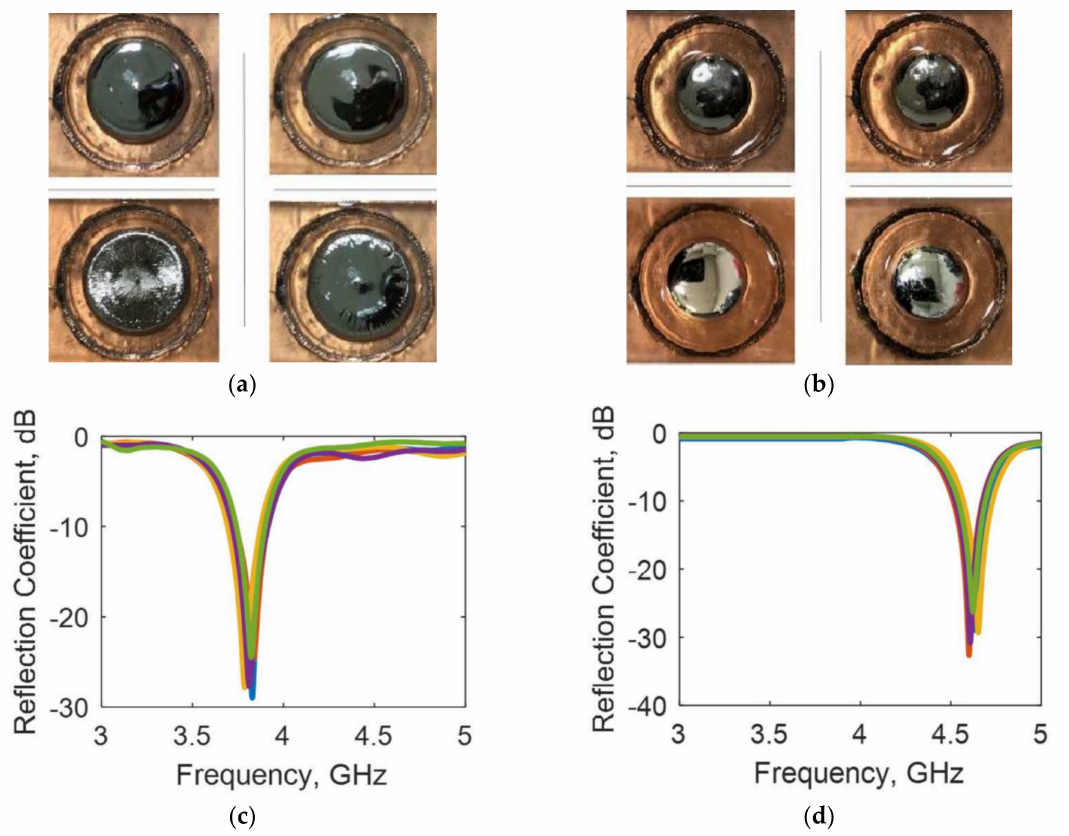
Figure 15. ( a ) EGaIn moved to a radius of 8 mm. ( b ) EGaIn moved to a radius of 6 mm. ( c ) Measured reflection coefficient of the unit cell with radius of 8 mm. ( d ) Measured reflection coefficient of the unit cell with radius of 6 mm. Reprinted with permission from Ref [27]. Copyright 2019